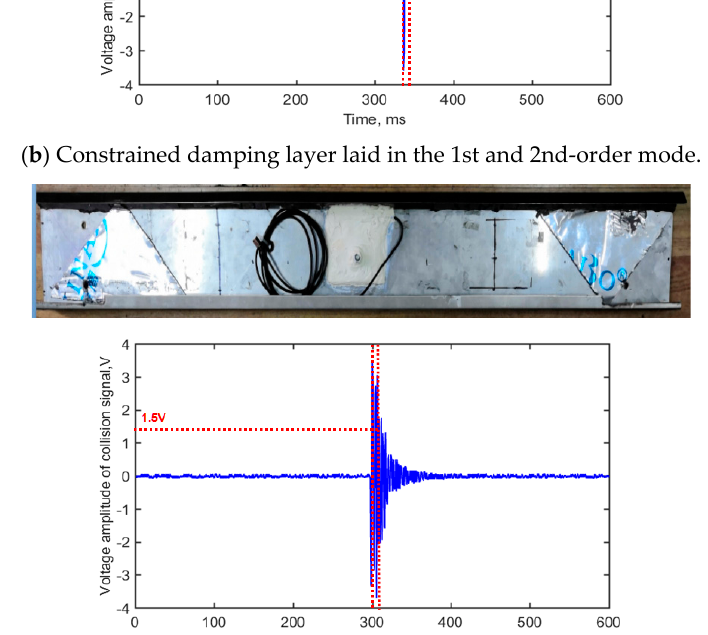
Figure 12. Grain collision signal waveform when damping layer on different locations. As can be seen from Figure 12a, when the constrained damping layer was laid in positions with maximum deformation values in the 1st-order modes, grain collision signal voltage amplitude is about 4.0 V, but the signal attenuation time is still long; on the basis